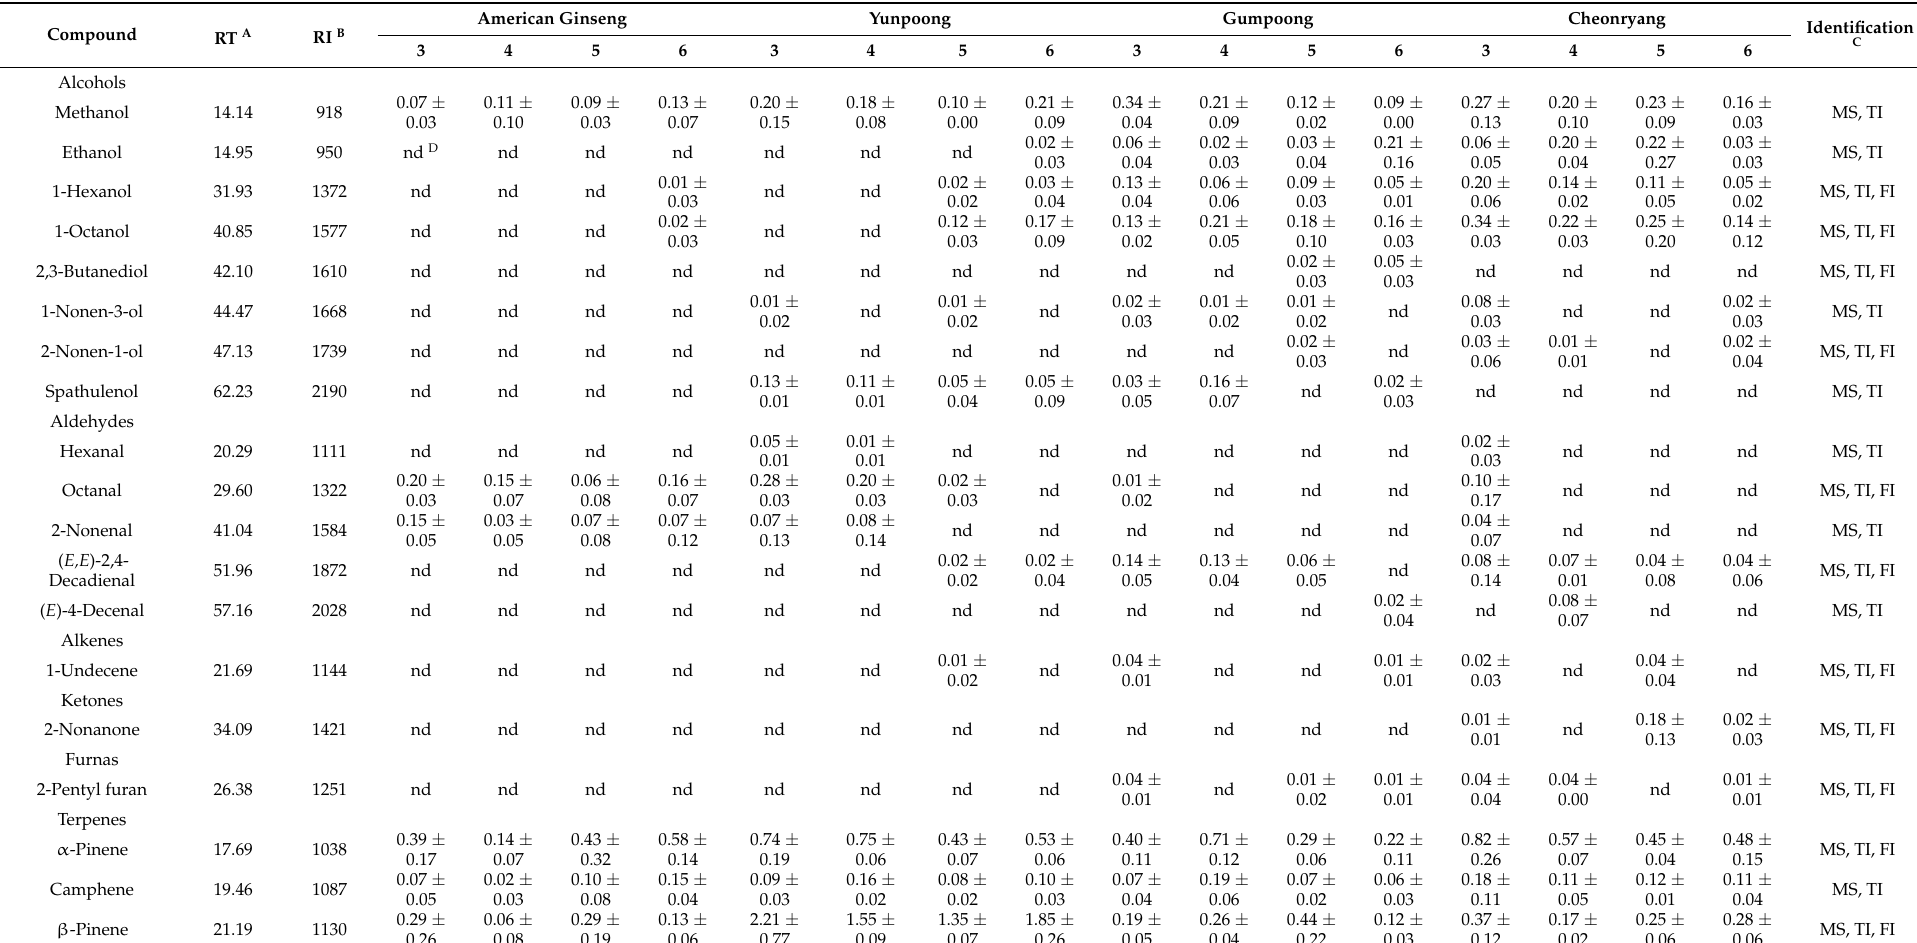
Table 1. Composition of volatile compounds in four different white ginseng roots grown for 3–6 years ( µ